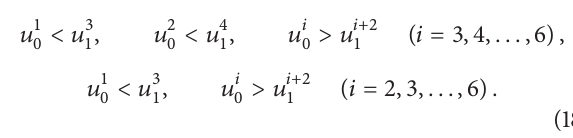
states with high level of oscillation, and every line or cluster formed by defectors is surrounded by oscillating cells with two periods. Figures 10(a) and 10(b) show the corresponding